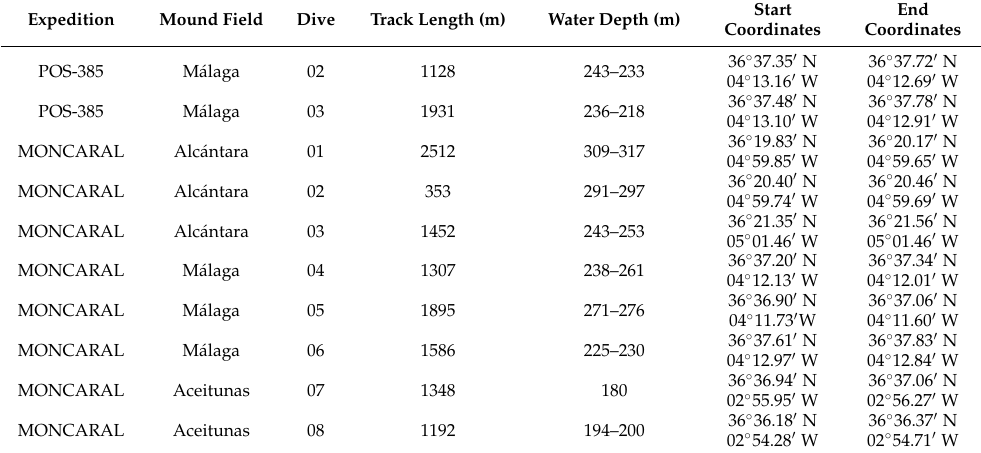
Table 1. Metadata of the ROV video transects recorded during POS-385 (ROV Cherokke) and MONCARAL 0516 (ROV Liropus 2000) expeditions in the northern Alboran Sea. Expedition Mound Field Dive Track Length